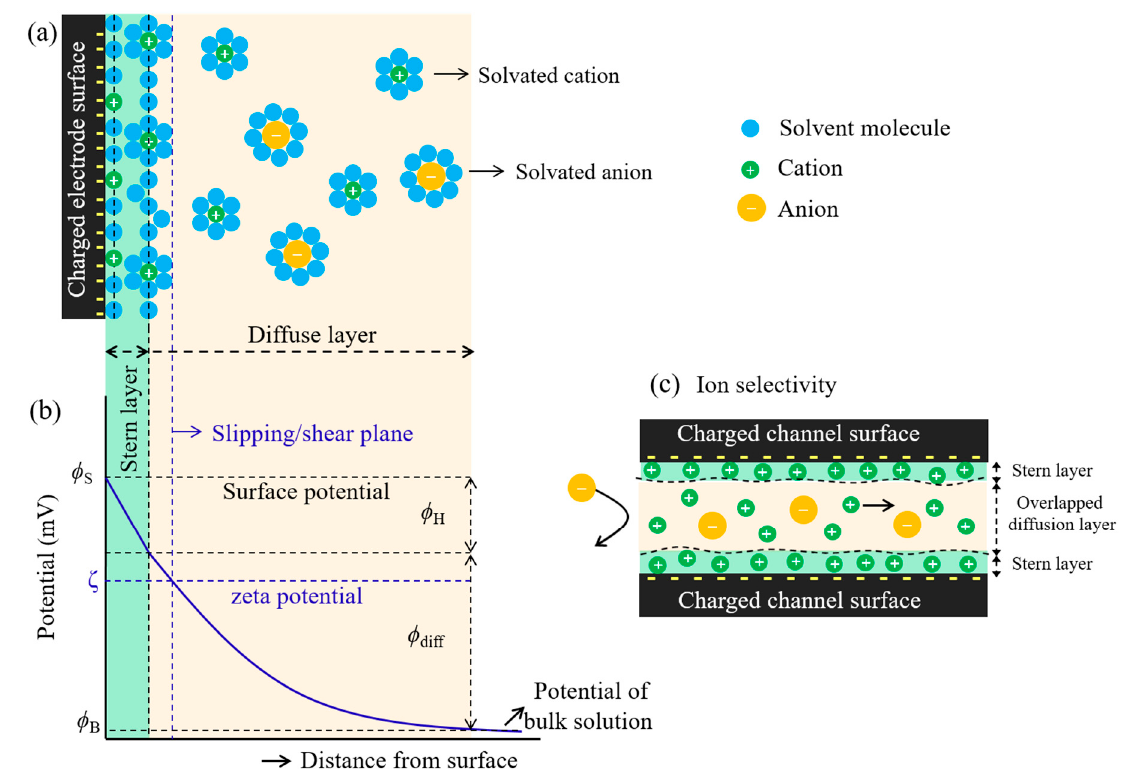
Figure 6. Schematic illustration of the electrical double layer (EDL). ( a ) The model of the EDL of the charged electrode surface immersed in the electrolyte solution at which negative potential bias is applied. ( b ) The potential profile of the electrode surface to the solution, which consists of the two steps of the decreasing potential as a function of the electrode distance. ϕ S , ζ , and ϕ B represent the potential at the electrode surface, slipping/shear plane (zeta potential), and the bulk electrolyte solution, respectively. ϕ H and ϕ diff are the potential of the Helmholtz plane and diffuse layer, respectively. ( c ) Ion selectivity inside the charged channel shows the two EDLs between the charged surfaces (overlapping diffuse layers), which allows counter-ions to pass through the channel but excludes co-ions.